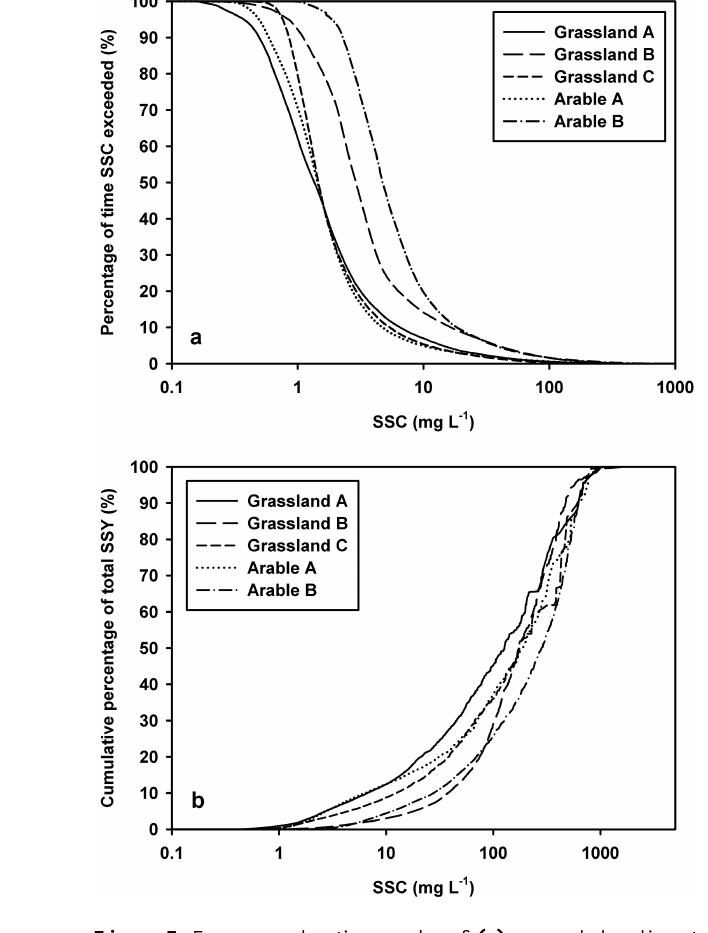
Figure 7. Frequency-duration graphs of (a) suspended sediment concentration exceedance with time and (b) cumulative percentage of suspended sediment yield with exceedance of suspended sedi- ment